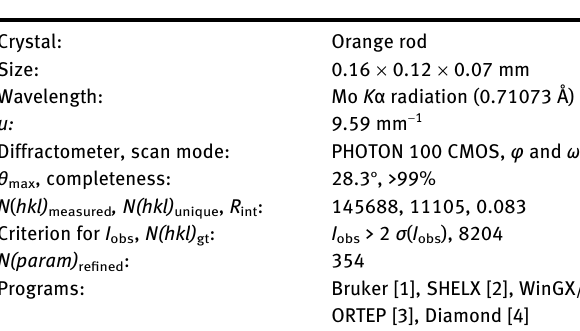
Table  : Data collection and